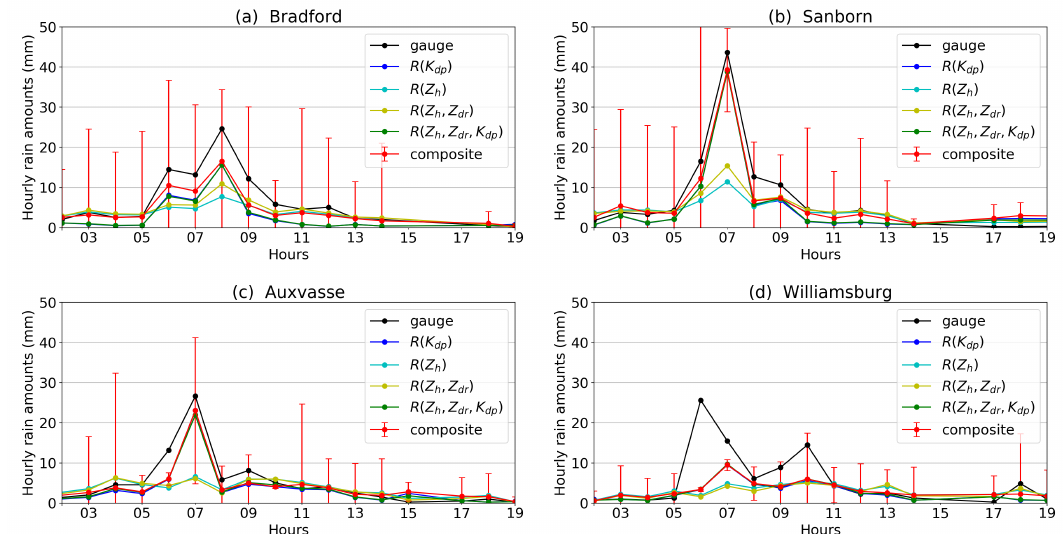
Figure 9. Time series of hourly rain amounts of RG (black), R ( K dp ) (blue), R ( Z h ) (cyan), R ( Z h , Z dr ) (yellow), R ( Z h , Z dr , K dp ) (green) and the composite method (red) at ( a ) Bradford, ( b ) Sanborn, ( c ) Auxvasse and ( d ) Williamsburg. The error bars represent the statistical uncertainties associated with the composite method. The data were collected between 0000 UTC and 2300 UTC on 3 July